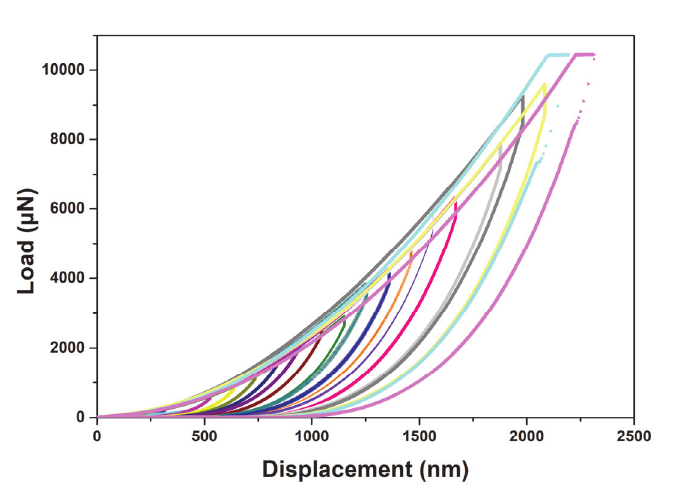
Figure 8: Load-unload curves as depth profile of PP with 2% CNTs